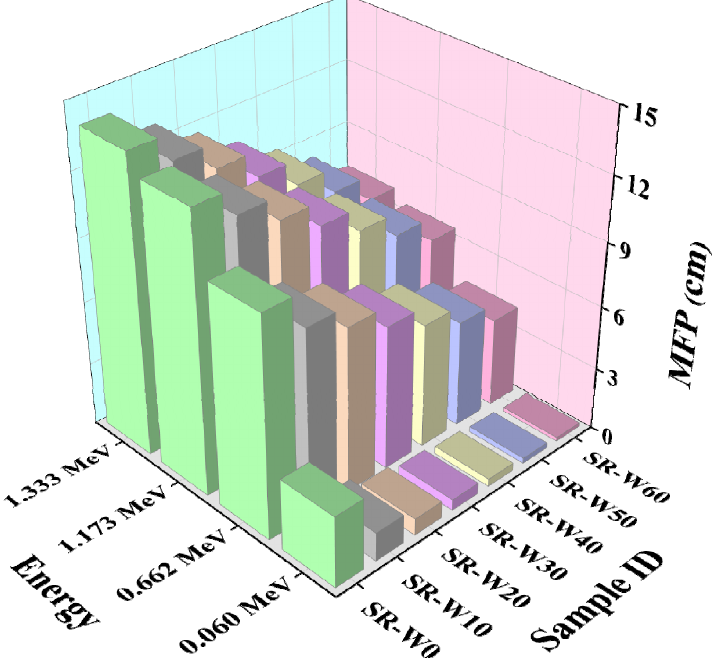
Figure 11. Pictorial presentation of the HVL of prepared silicone rubber (SR-W) systems with the function of energy.